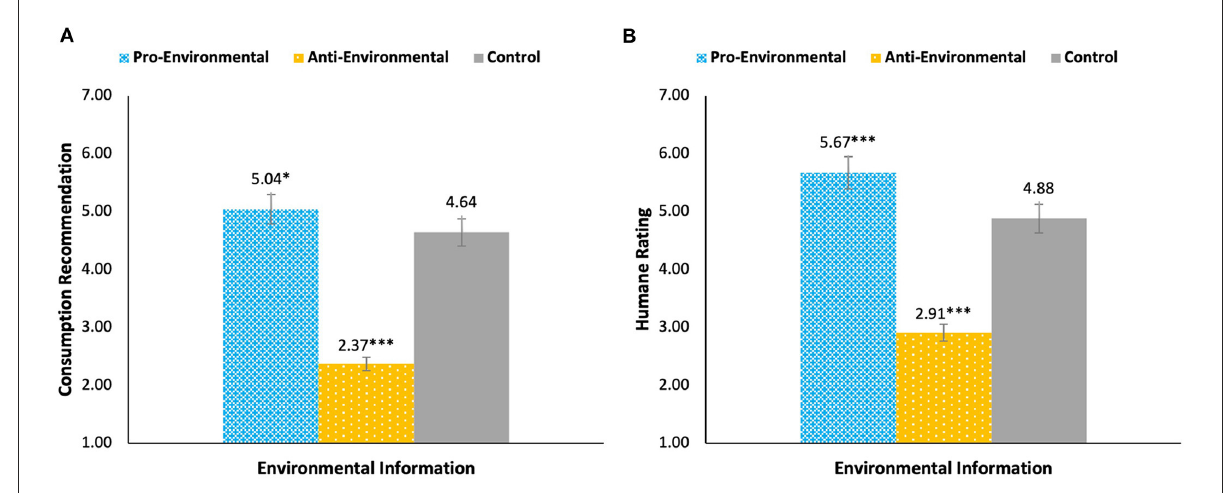
FIGURE1 Mean scores for (A) cheese consumption recommendations and (B) judgment of dairy cow treatment, across the three conditions. Error bars correspond to 95% confidence intervals. Asterisks indicate significant differences versus the control condition, * p < 0.05 and *** p < 0.001.